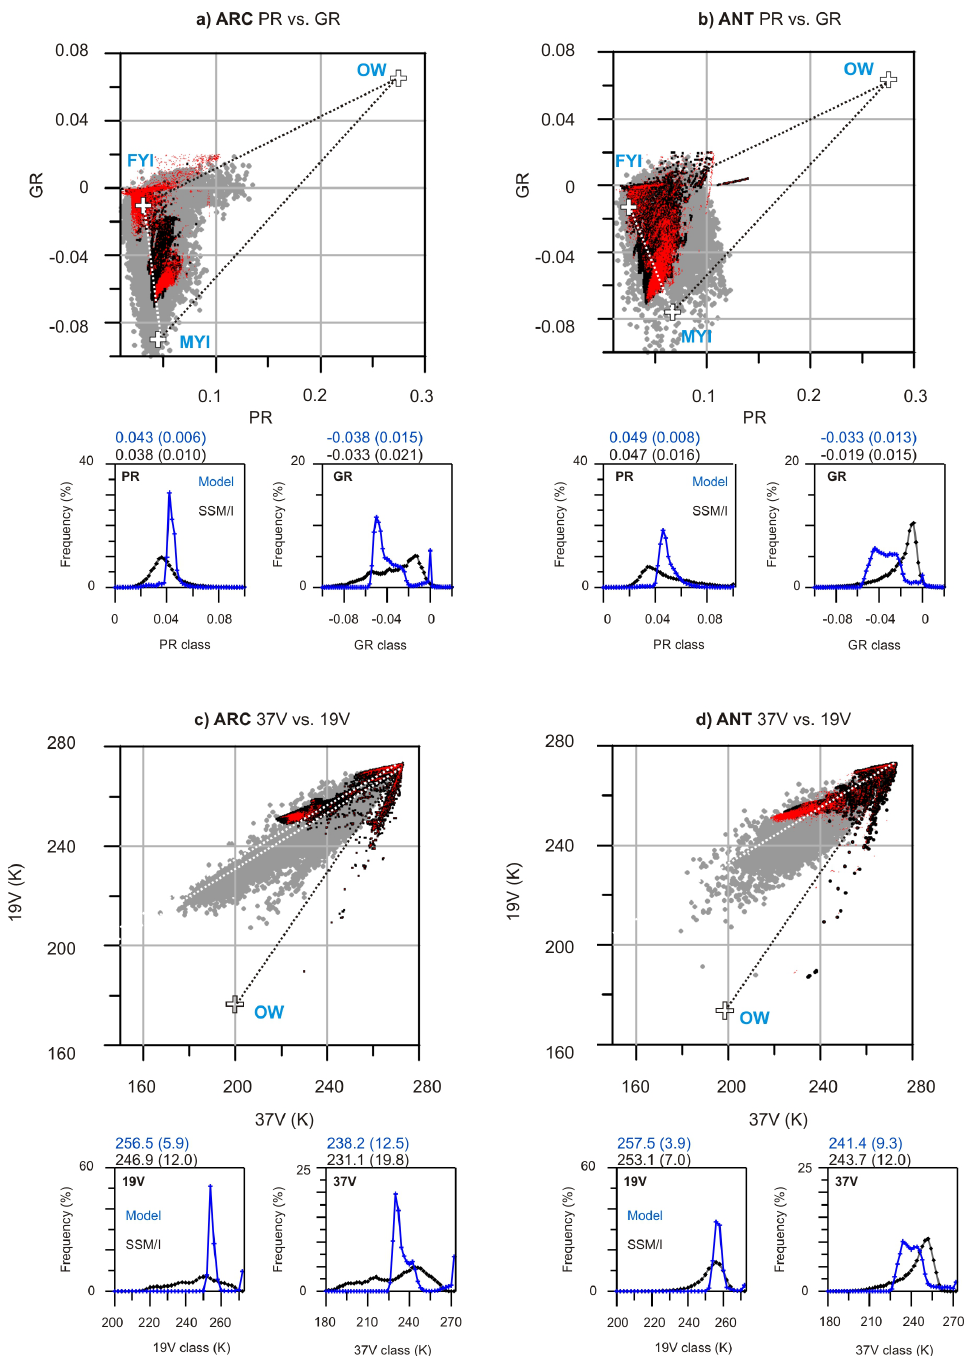
Fig. 2. Simulated polarization and gradient ratios (PR, GR, black) for the Arctic ( a , January to June) and Antarctic ( b , July to December) and brightness temperatures at 37V and 19V for the Arctic (c) and Antarctic (d) , 4 times daily data, 2000–2009. Red dots indicate last month of simulations. Daily values of observed satellite Tb for area with sea-ice concentrations above 90% are shown by grey dots for comparison. Tie points for open water (OW) and (in a , b only) first-year ice (FYI) as well as multi-year ice (MYI) are indicated by crosses. 100% sea-ice concentration lines are shown by white dotted lines, while different lines in (c) show lines for summer and winter, respectively. (a) – (d) with frequency distributions of modelled (blue) and observed data (black, values extracted where sea-ice concentrations exceeds 90%). The means and standard deviations are indicated by